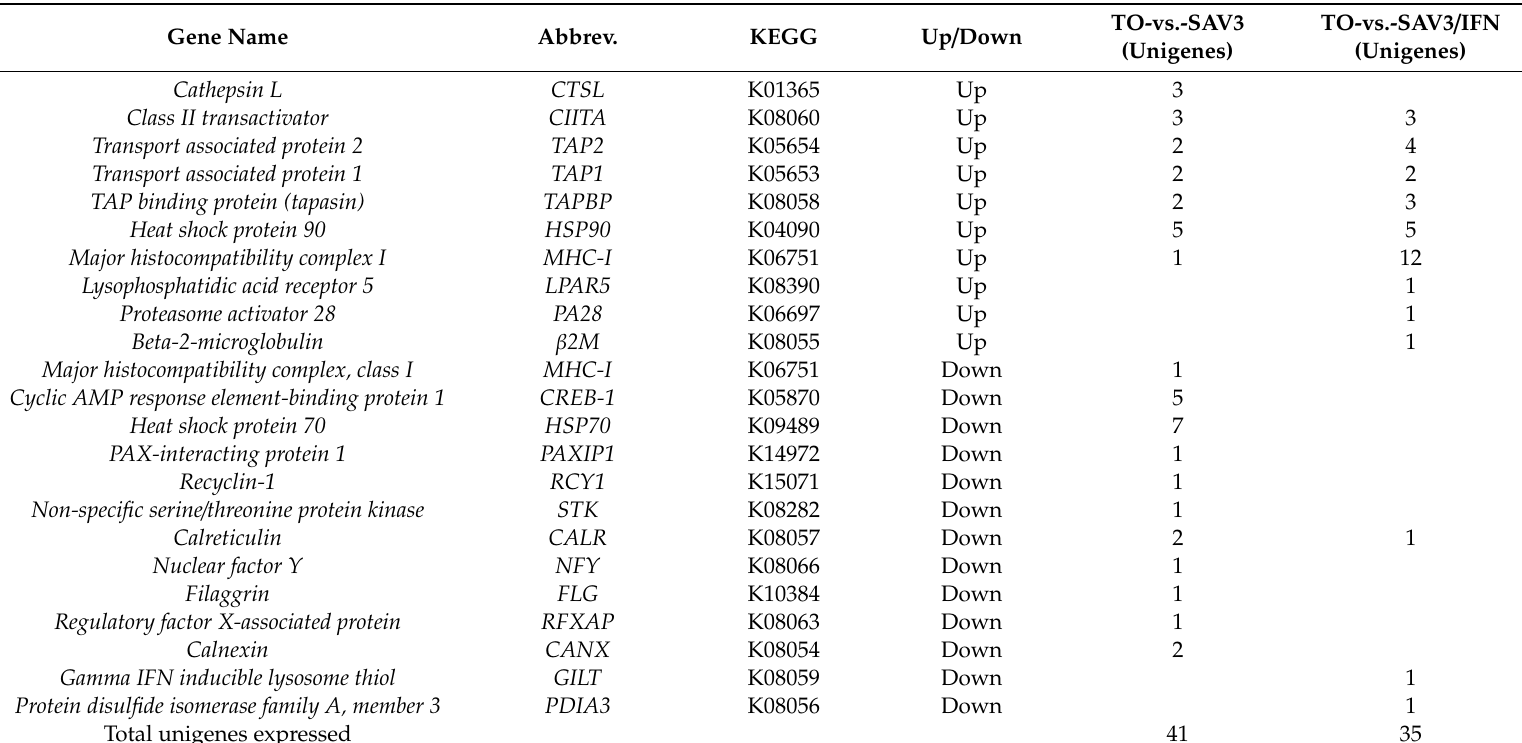
Table 3. Summary of number of antigen processing and presentation unigenes expressed in TO-vs.-SAV3 / IFN and